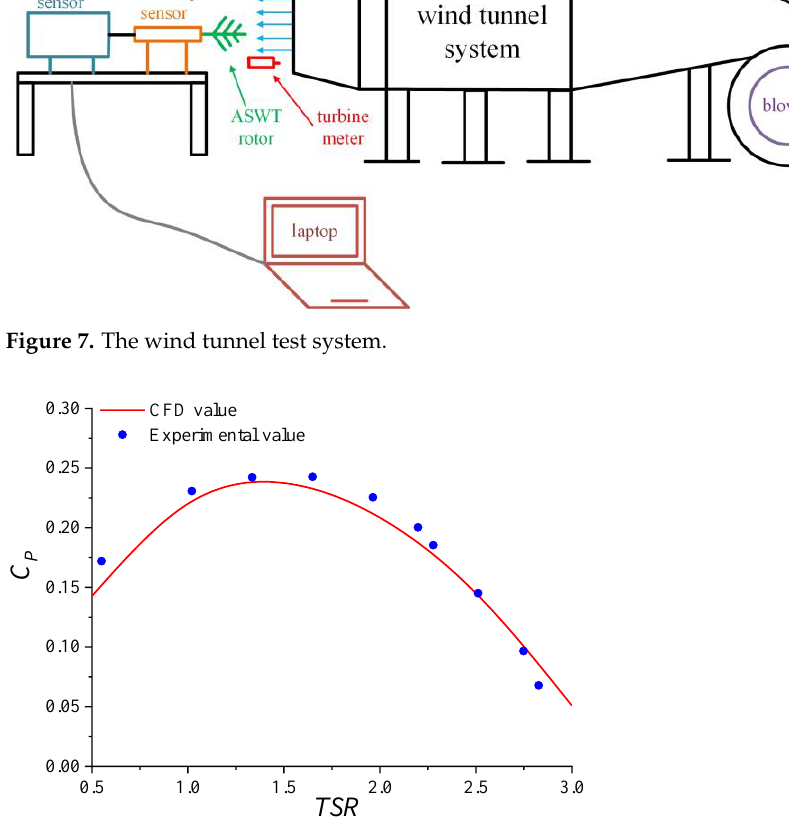
Figure 8. Comparison between the experimental value and the CFD value.